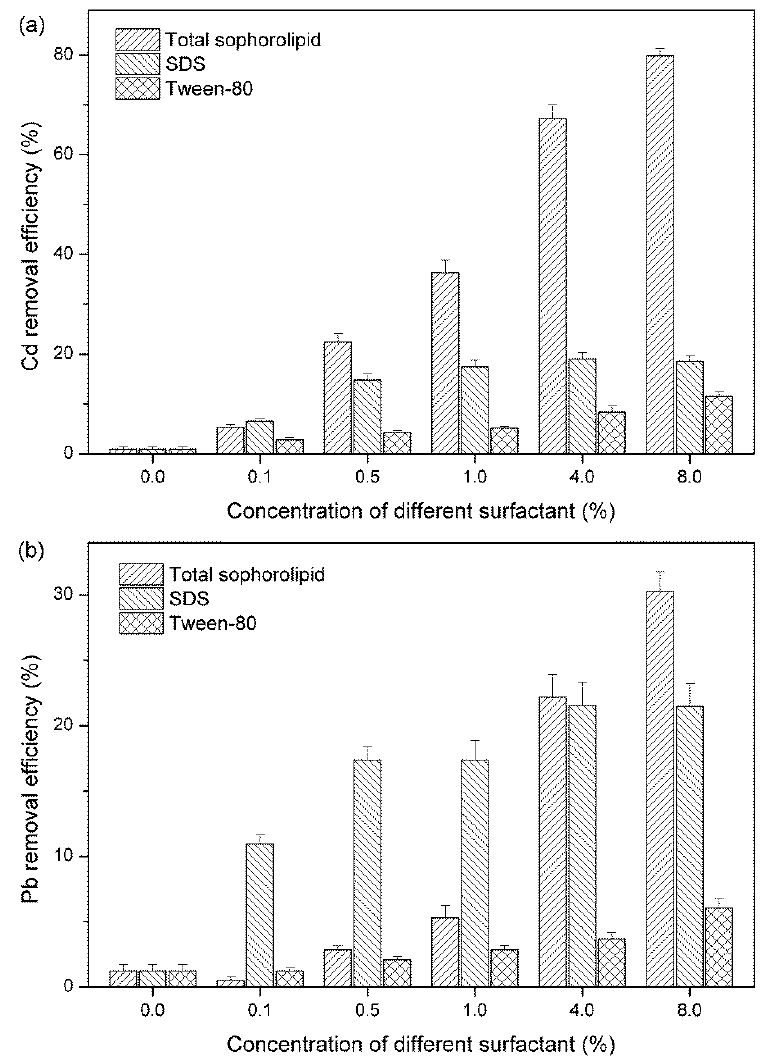
Figure 1. Removal efficiency of Cd ( a ) and Pb ( b ) after batch washing with crude total SLs and synthetic surfactants.